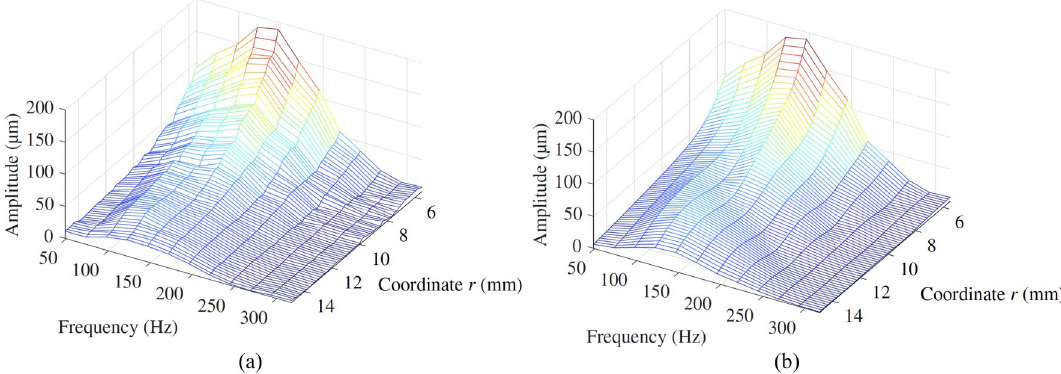
Figure 15. Amplitude spectrum from ( a ) the HSC test and ( b ) the model simulation, for the illustrative case in plane